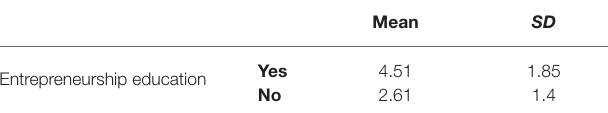
TABLE 3 | Means and standard deviations of founding passion by entrepreneurship